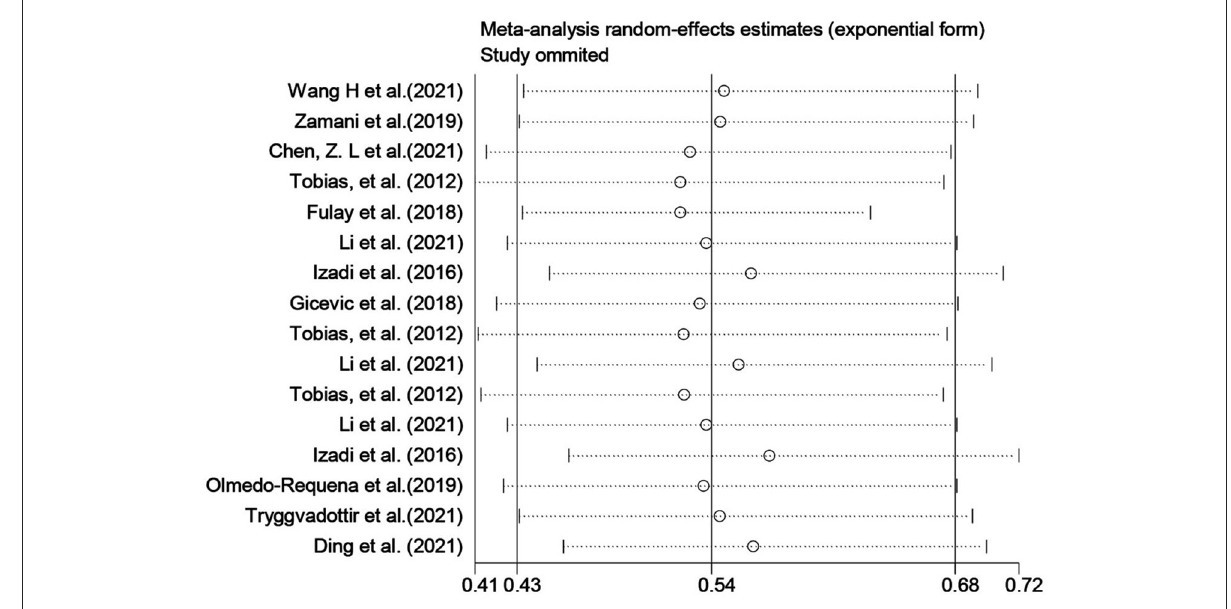
FIGURE4 Group A sensitivity analysis.